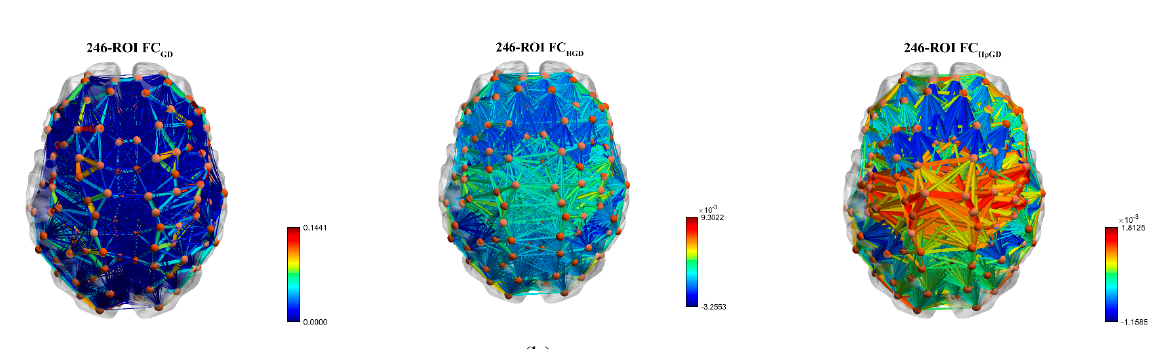
Figure 4. The mean empirical FC network vs. the mean predicted FC networks by the three models. ( a ) The 90 ROIs dataset. Fig. 4 The mean empirical FC network vs the mean predicted FC networks by the three models. (a) 90 ROIs ( b ) The 246 ROIs dataset. (b) 246 ROIs datasets.